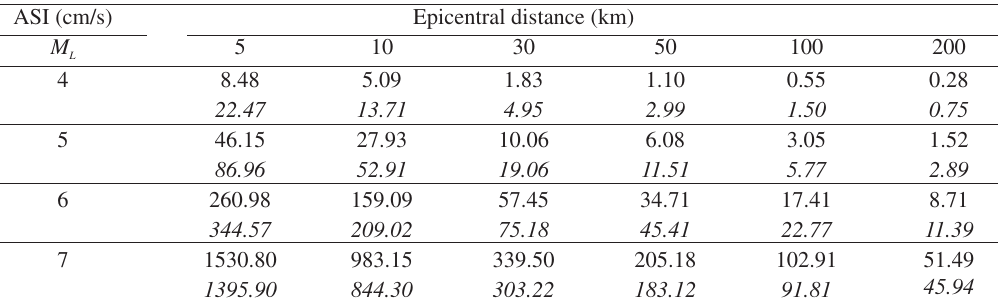
Table V. Values of acceleration spectrum intensity (ASI, in cm/s) for rock sites, using the PSV attenuation relationships ZM02 and SP96 (numbers in italics correspond to SP96). ASI (cm/s) Epicentral distance (km) M L